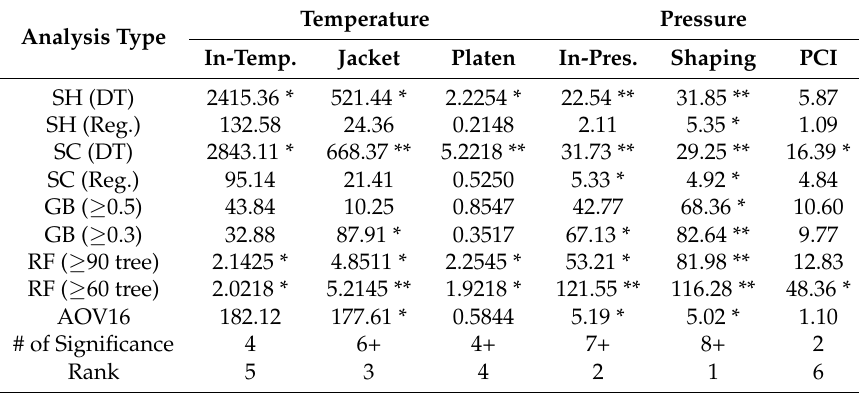
Table 5. Result of 1st-round